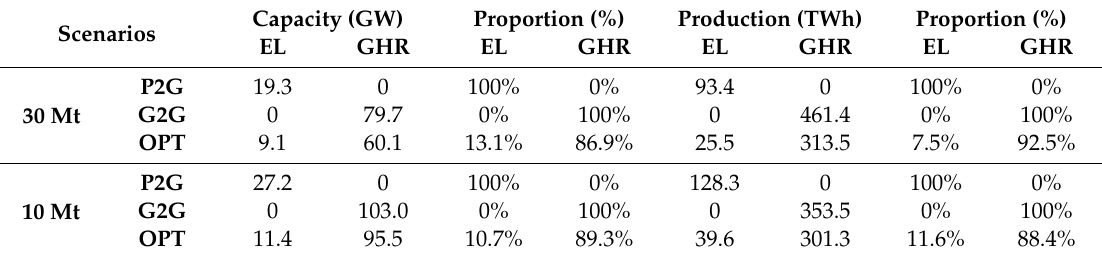
Table 4. Capacity and the annual output of different hydrogen production technologies.